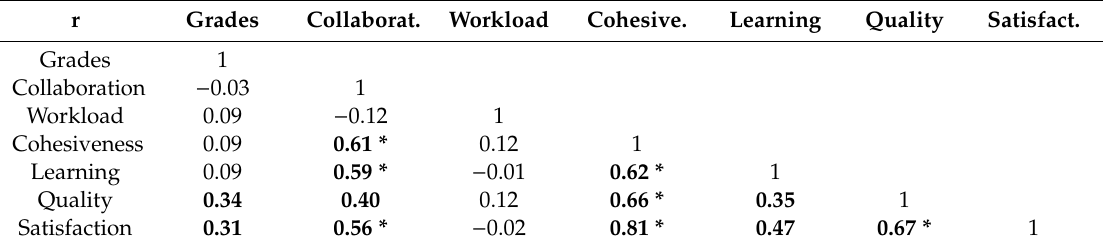
Table 4. Pearson’s correlation analysis (* Correlation significance < 0.01).